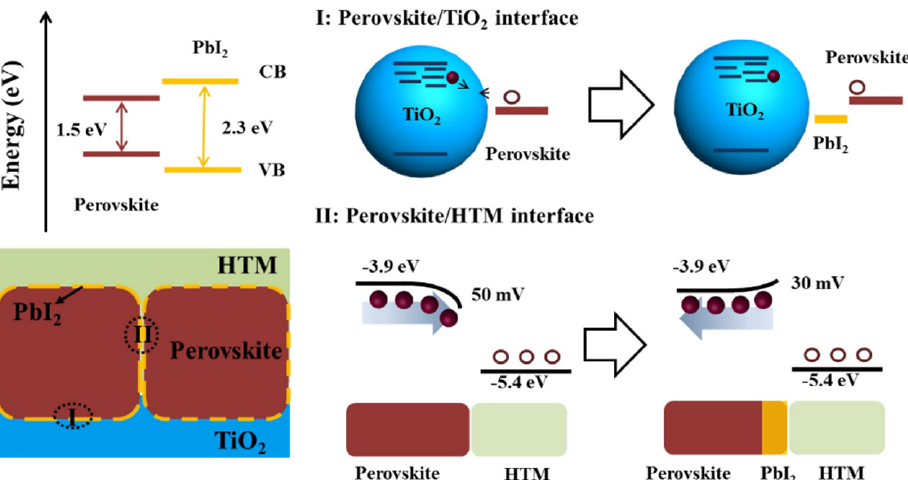
Figure 1. Energy alignment and bandgap of PbI 2 and perovskite is shown on the top left. The schematic n-i-p structure is shown on the bottom left. ( I ) The interface of perovskite/TiO 2 before and after the introduction of PbI 2 is described on the top right. ( II ) The interface of perovskite/HTM before and after the introduction of PbI 2 is shown on the bottom right. Reprinted with permission from reference [12]. Copyright (2014) American Chemical Society.